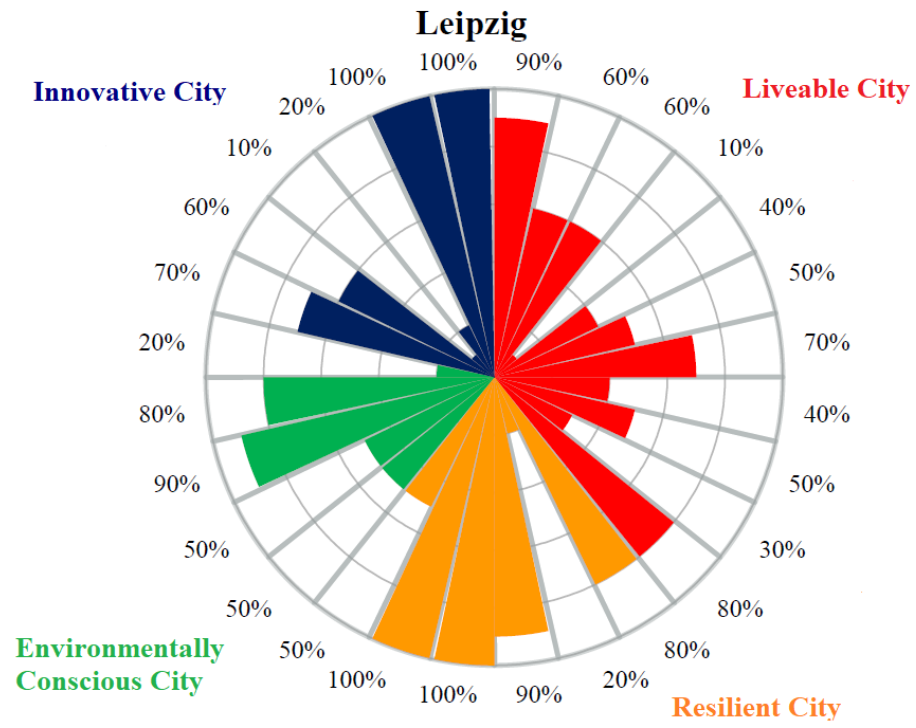
Figure 3. Leipzig City Index assessment.